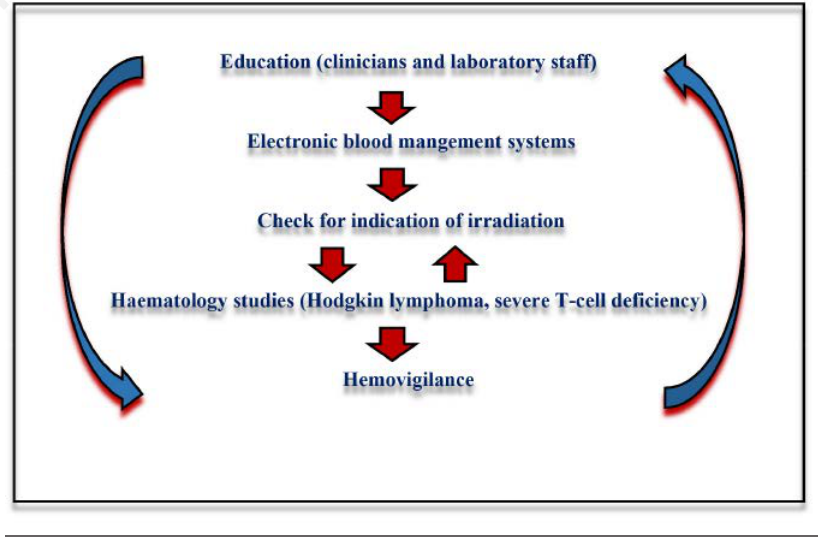
Figure 1. Key points of blood safety, focus on Transfusion-associated graftversus-host dis-